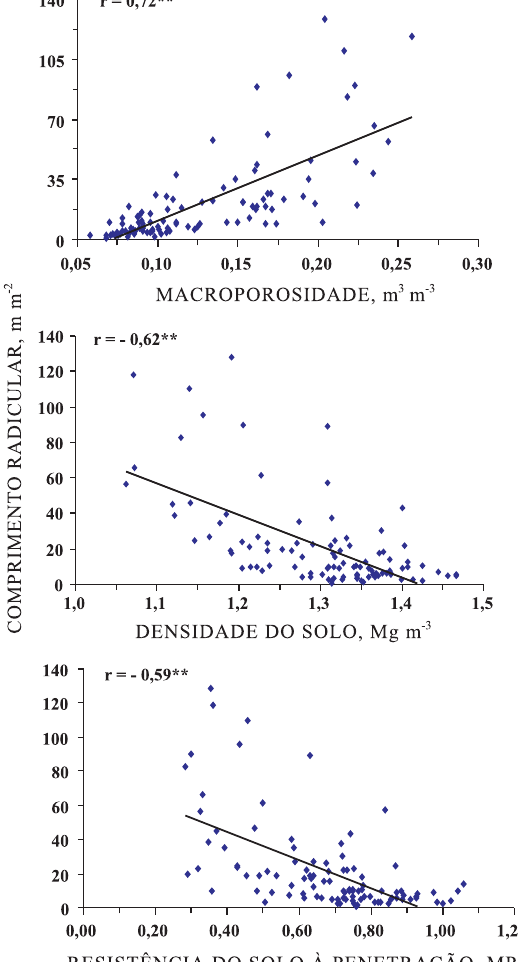
Figura 3. Comprimento radicular de acordo com a macroporosidade, densidade do solo e resistência do solo à penetração em Latossolo Vermelho distroférrico de textura muito argilosa. **significativo pelo teste t a 1 %. Camada de 0,0–0,20 m (n =